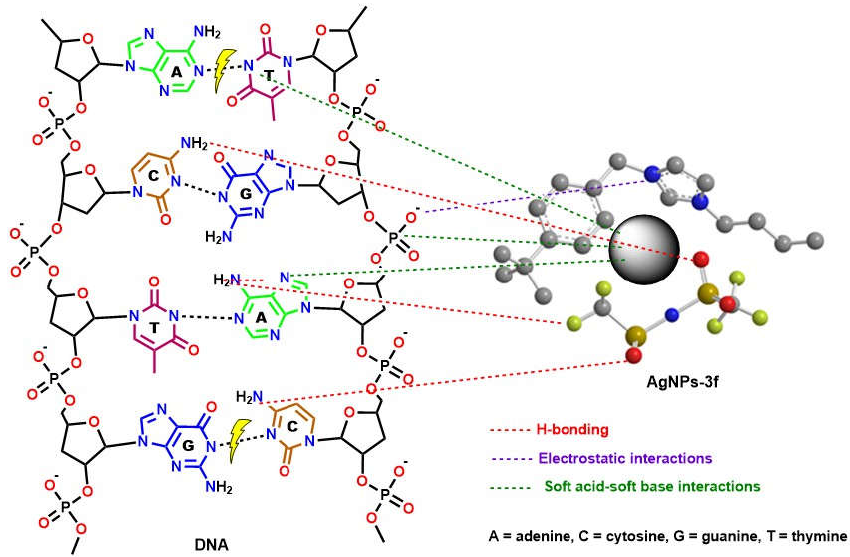
Figure 9. The proposed mechanism for DNA-cleavage activity of new thiazolium AgNPs-3f.